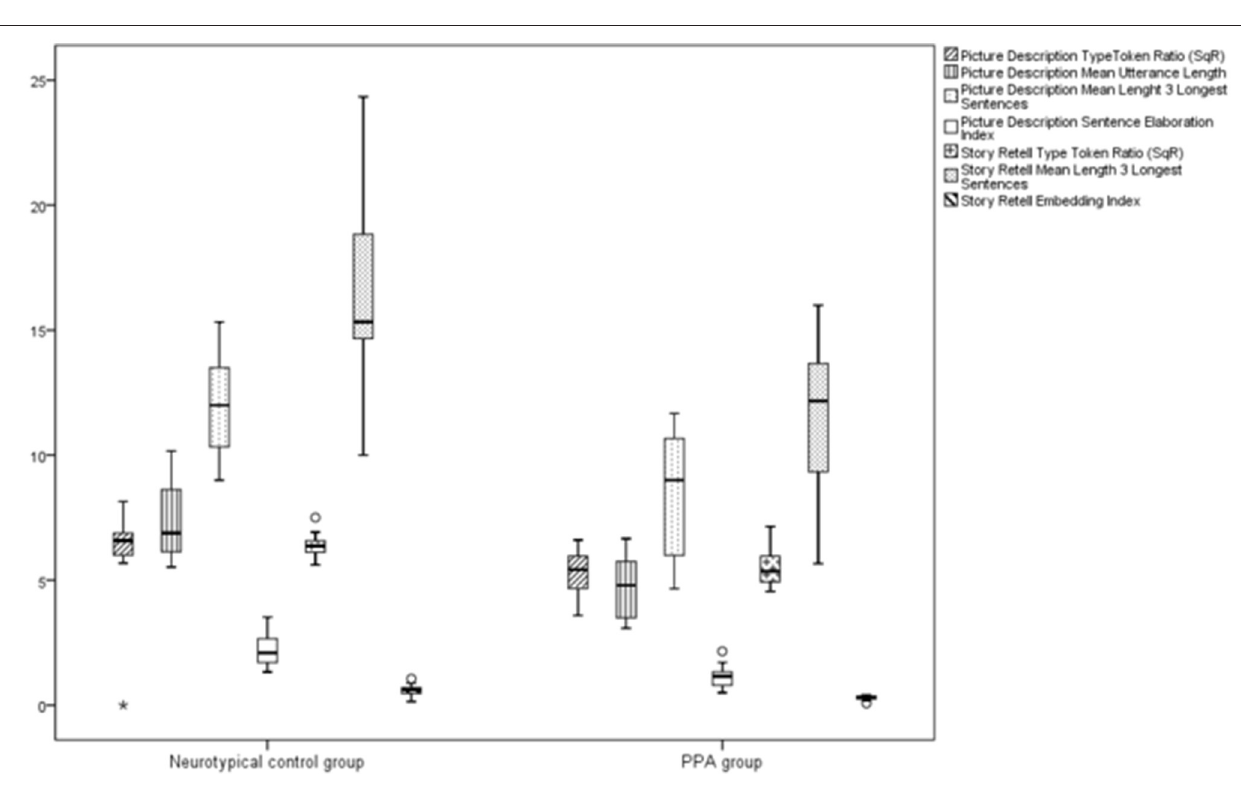
are also affected (Macoir et al., 2017). However, the executive tasks that were included in the assessment battery are not “pure”. For example, the TMT relies on fine-motor skills